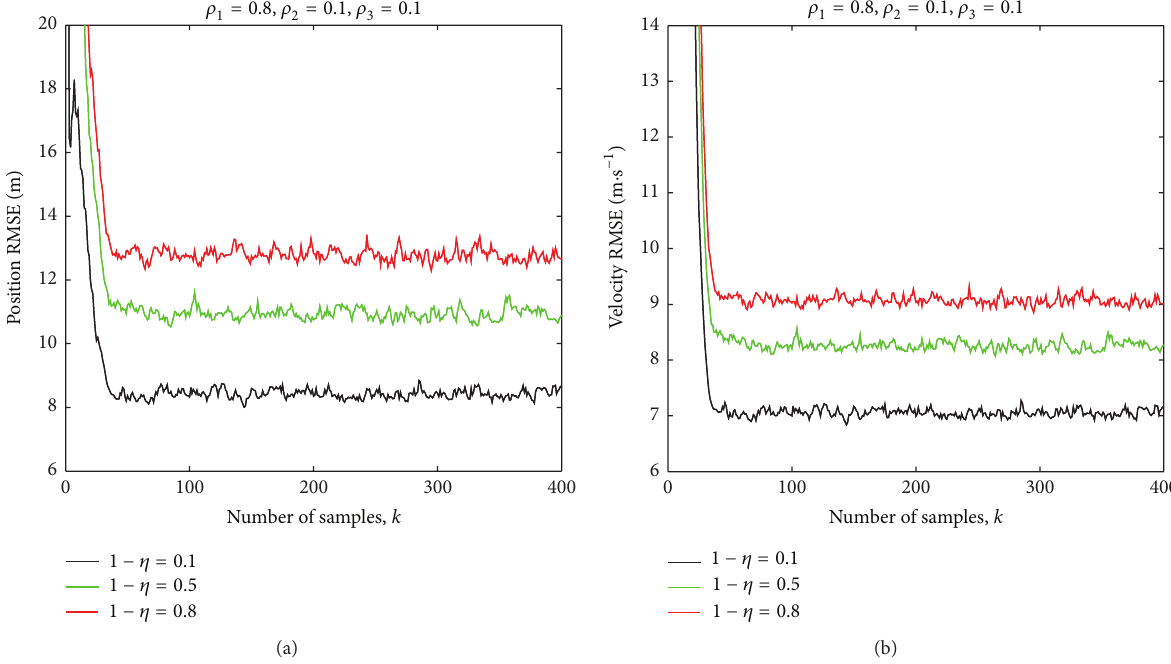
Figure 12: Comparison of the RMSEs for the proposed algorithm with different 𝜌 𝑞 (𝑞 = 1, 2, 3) : (a) position RMSE; (b) velocity RMSE.